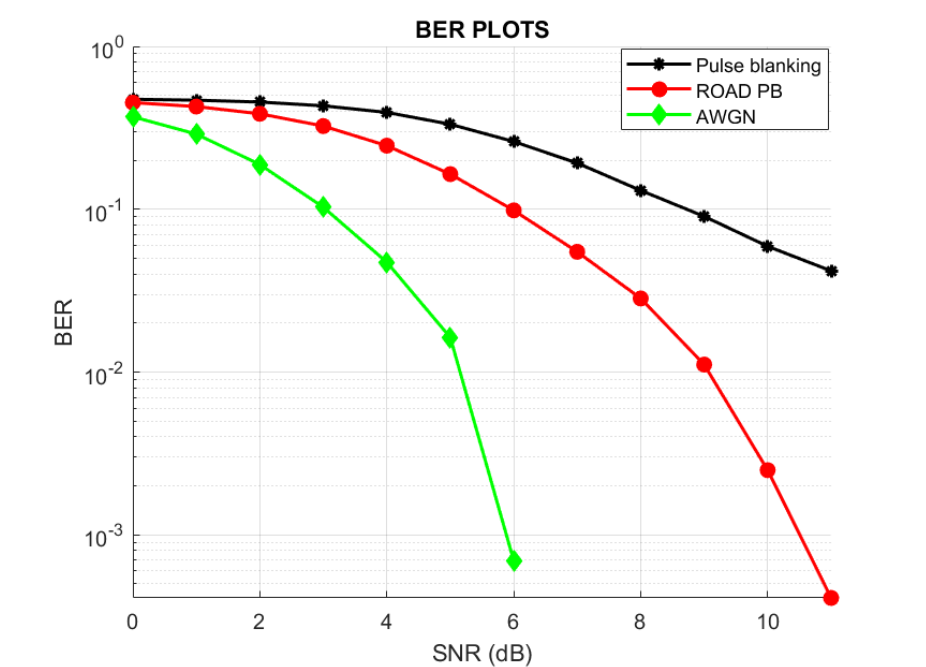
Figure 23. Performance of ROAD PB vs. pulse blanking.